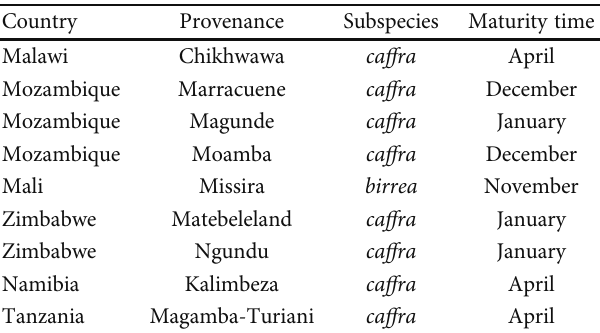
Figure 2: Phenotype of mature Sclerocarya birrea fruit. Table 1: Sampling time of Sclerocarya birrea populations (countries and provenances).